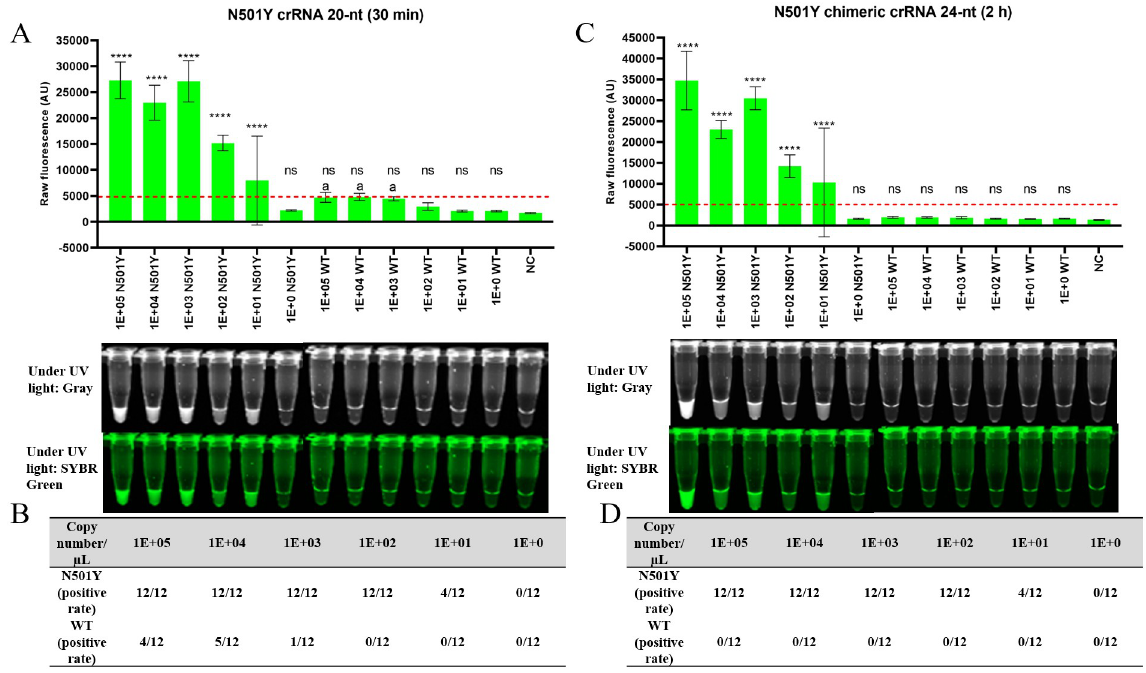
Fig 2. Specificity of different crRNAs using synthetic RNA containing gene fragments of SARS-CoV-2. (A) Detection of N501Y variant and wild type using N501Y crRNA 20-nt after incubation for 30 min. The (a) indicates false positive fluorescence signal of the wild type. (B) Table summarizing positive rate (visualization of the tube) of N501Y and wild type when using N501Y crRNA 20-nt after incubation for 30 min. (C) Detection of N501Y variant and wild type using N501Y chimeric crRNA 24-nt after incubation for 2 h. No false positive signal was obtained. (D) Table summarizing positive rate (visualization of the tube) of N501Y and wild type when using N501Y chimeric crRNA 24-nt after incubation for 2 h. The horizontal red dashed lines indicate the threshold fluorescence signal that can be visualized under UV light. The threshold level of 5000 AU has been determined for visualizing under UV light and validated against spectrophotometry reading. Tenfold serial dilutions (copy number per μ L) of synthetic RNA containing gene fragments of SARS-CoV-2 was used. Four replicates were run for each time and repeated three times (n = 12). NC stands for non-template control. Error bars represent the standard deviation of the mean. For (A) and (C), statistical analysis was performed using a one-way ANOVA test with Dunnett’s multiple comparisons test. Where the raw fluorescence (AU) of each reaction was compared to the respective NCs. The asterisks ( � , �� , ��� , ���� ) indicate significant differences with p < 0.05, p < 0.01, p < 0.001, and p < 0.0001 and ns denotes not significant ( p >